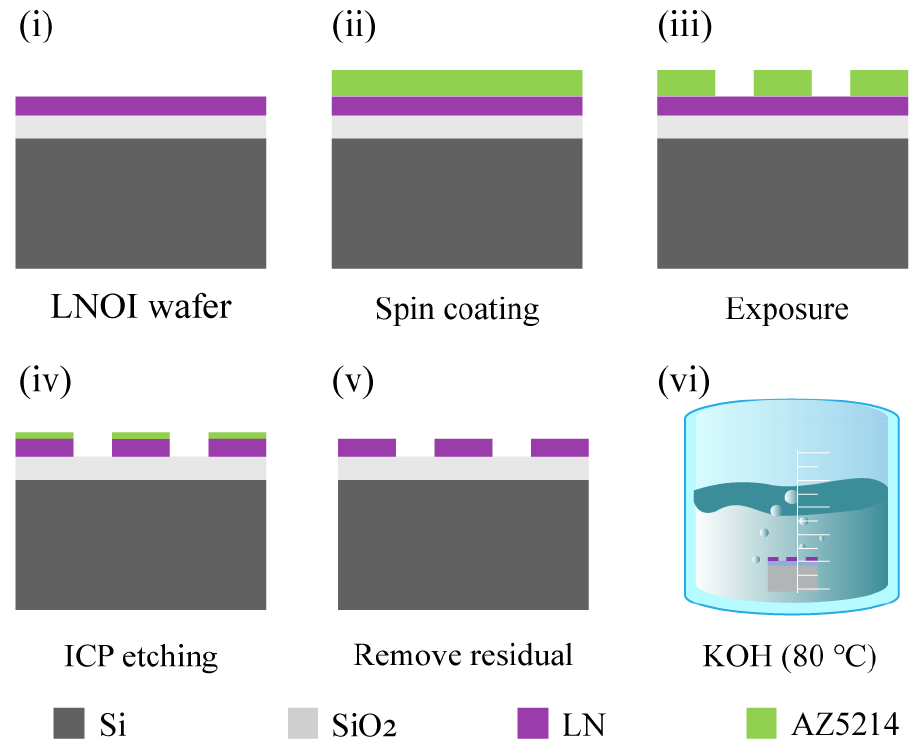
Figure 2. The device fabrication process. ( i ) The x-cut LNOI wafer; ( ii ): Spin-coating photoresist; ( iii ) Defining the pattern of the LN metasurface by Stepper lithography; ( iv ) Transferring the pattern of the LN metasurface onto the LN layer by inductively coupled plasma (ICP) etching; ( v ) Removing the residual resist; ( vi ) The fabricated LN metasurface was immersed in 0.5 mol/L KOH solution at 80 °C for 20 min to further improve the etching quality.